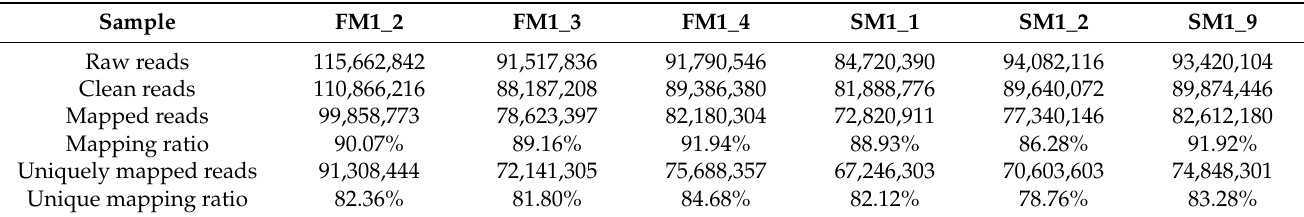
Figure 1. The experimental design of this study. Table 1. Summary of reads mapping to the M. amblycephala reference genome.